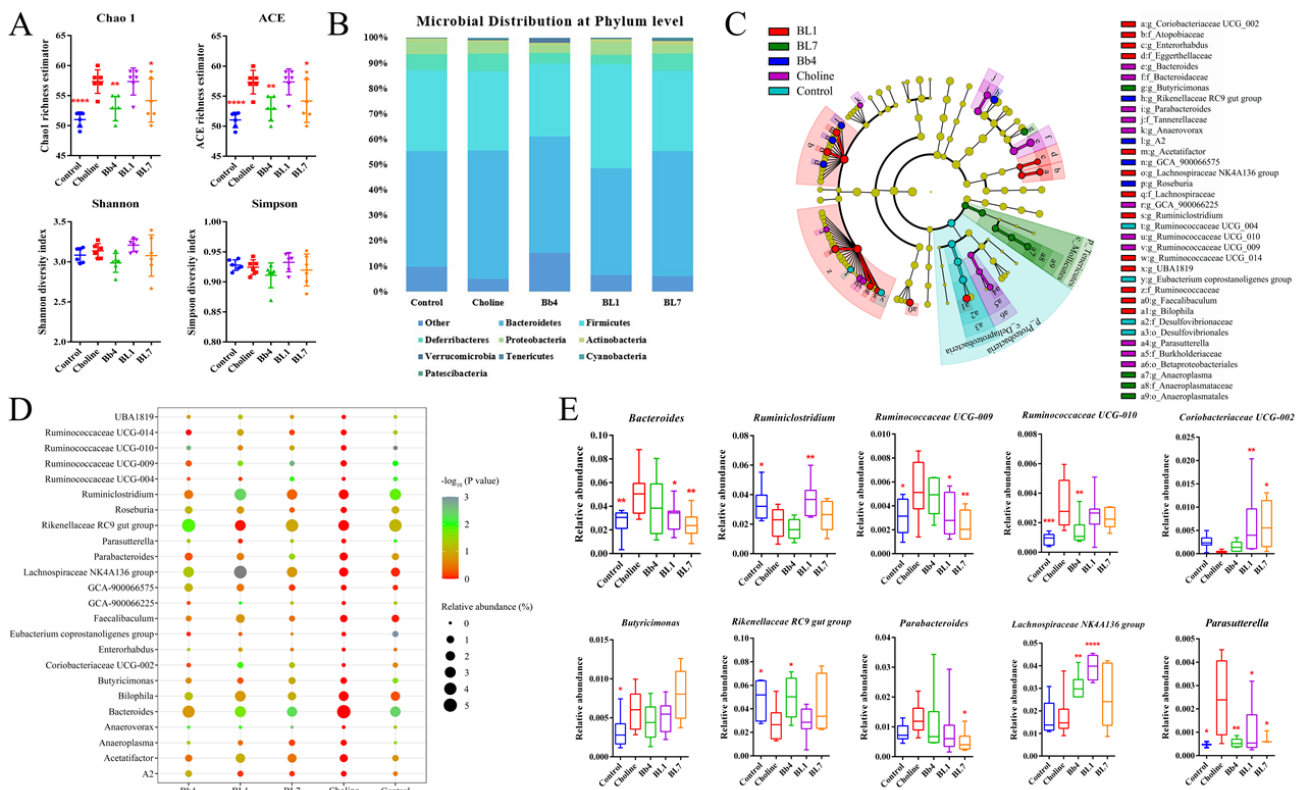
Figure 7. Bifidobacterium modulated the composition of gut microbiota: ( A ) α diversity of cecal microbial, ( B ) microbial distribution at phylum level; ( C ) plot LEfSe cladogram of cecal microbial, LDA > 2, p < 0.05; ( D ) Pretty Heatmap of cecal microbial, X -axis means the group, Y -axis means the genus, the color means the significance ( p value), and the circle size means the relative abundance; ( E ) relative abundance of the genus level. Values are mean ± SD, six mice per group. * p < 0.05, ** p < 0.01, *** p < 0.001, **** p < 0.0001 versus the choline group.